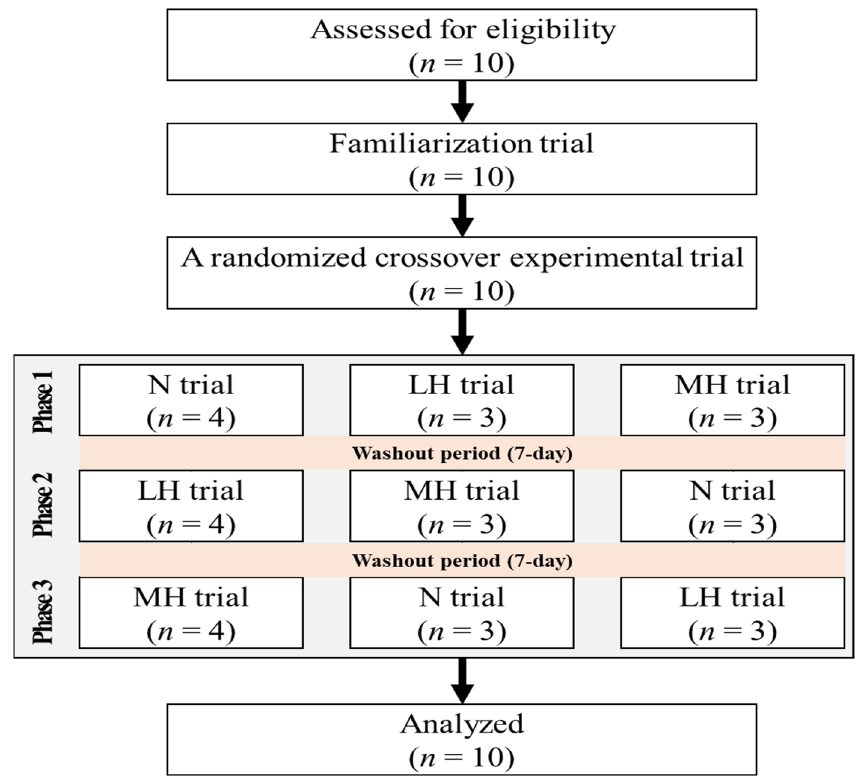
Figure 1. The flow diagram of the consolidated standards of reporting trial. N: endurance submax- imal exercise under normoxia; LH: endurance submaximal exercise under light hypoxia (596 mmHg, simulated 2000 m); MH: endurance submaximal exercise under moderate hypoxia (526 mmHg, simulated 3000 m).